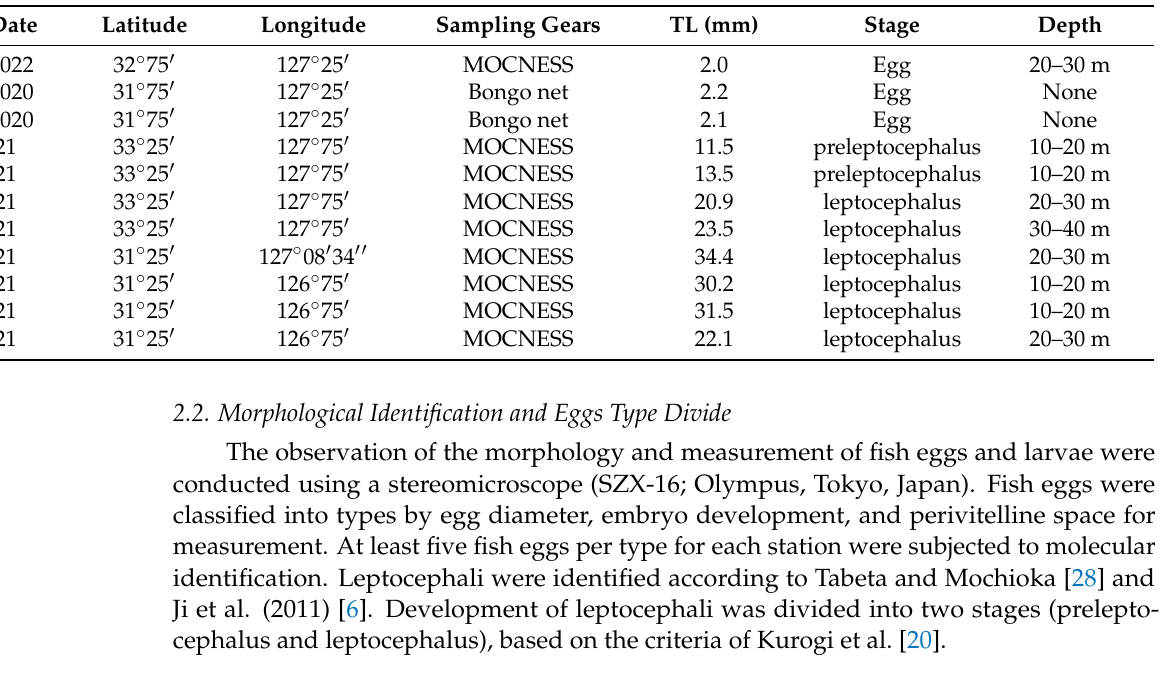
Figure 1. Location of sampling stations of Muraenesox cinereus eggs and preleptocephali in waters adjacent to Jeju Island in August 2020 and 2022. White dots indicate stations where M. cinereus eggs were collected. White squares indicate stations where M. cinereus preleptocephali and leptocephali were collected. Black dots show sampling stations using the bongo net. Red triangles show sampling stations using Multiple Opening/Closing Net and Environmental Sensing System (MOCNESS). Table 1. List of Muraenesox cinereus eggs and leptocephali collected from offshore of Jeju